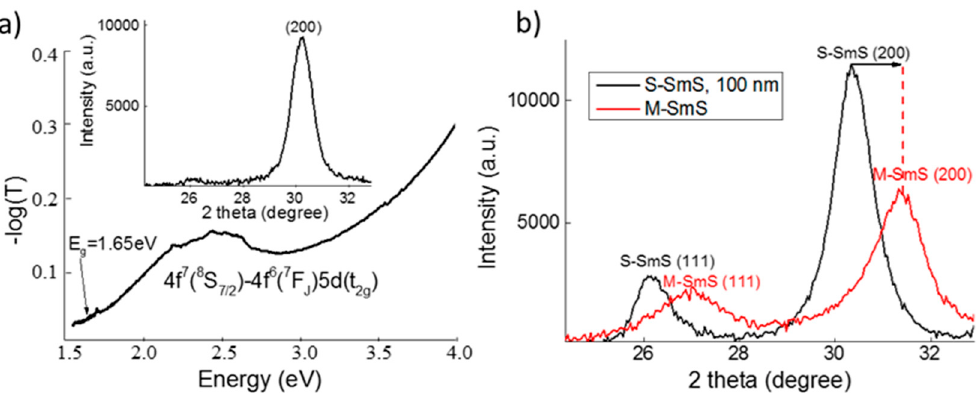
Figure 2. Basic properties of the deposited SmS and EuS thin films. ( a ) Optical (on glass) and structural (inset, on Si wafer) fingerprint of a 25 nm as-deposited EuS. ( b ) XRD patterns showing the structural behavior in the as-deposited (black line) S-SmS, as well as in the metallic state (red line), after rubbing. The lattice planes are indicated. In both thin film depositions, the substrate temperature was 250 °C.